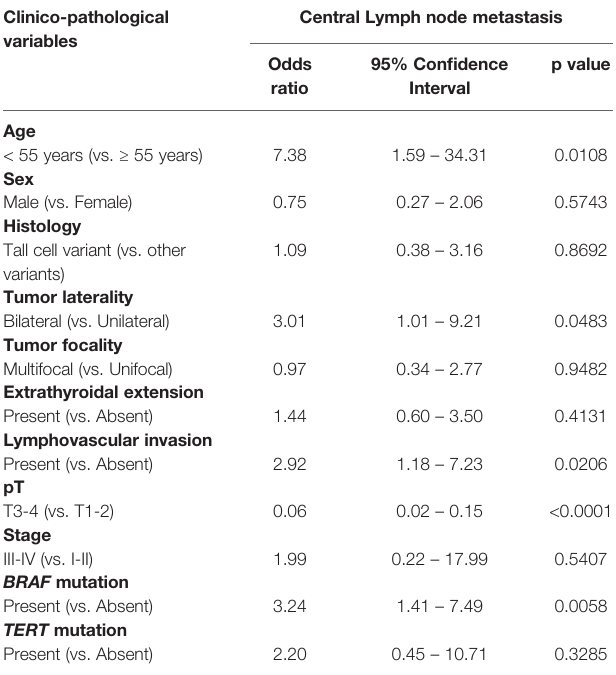
TABLE 3 | Independent predictors of central lymph node metastasis by multivariate logistic regression analysis. Clinico-pathological variables